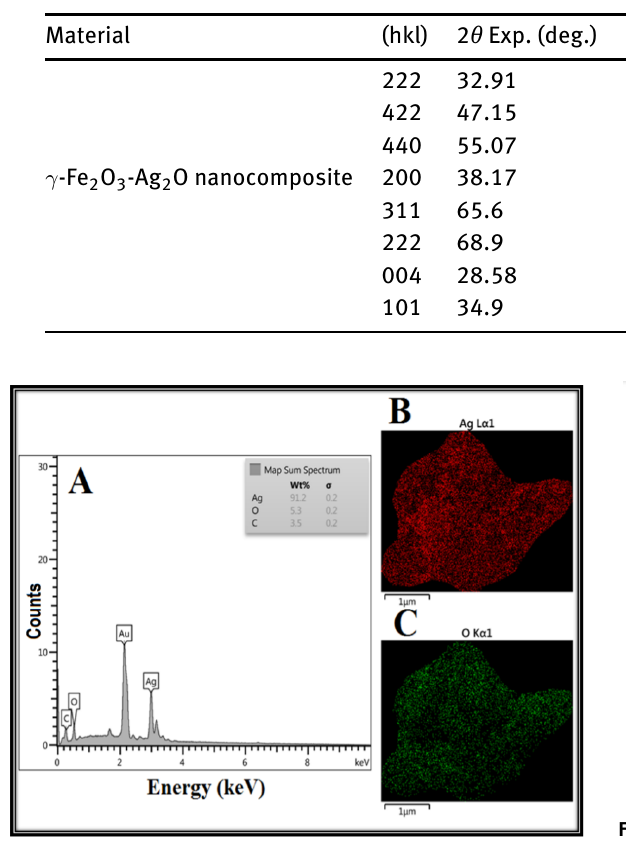
Figure 3: (A) EDS spectrum of 𝛾 -Fe 2 O 3 -Ag 2 O nanocomposite and its corresponding elemental mapping images for (B) silver and (C) oxygen.